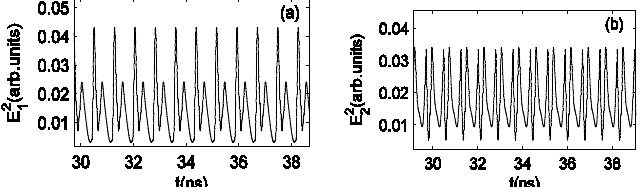
Fig. 6. Different double-cycle oscillations of two lasers. (a) a double-cycle of laser 1. (b) another double-cycle of laser